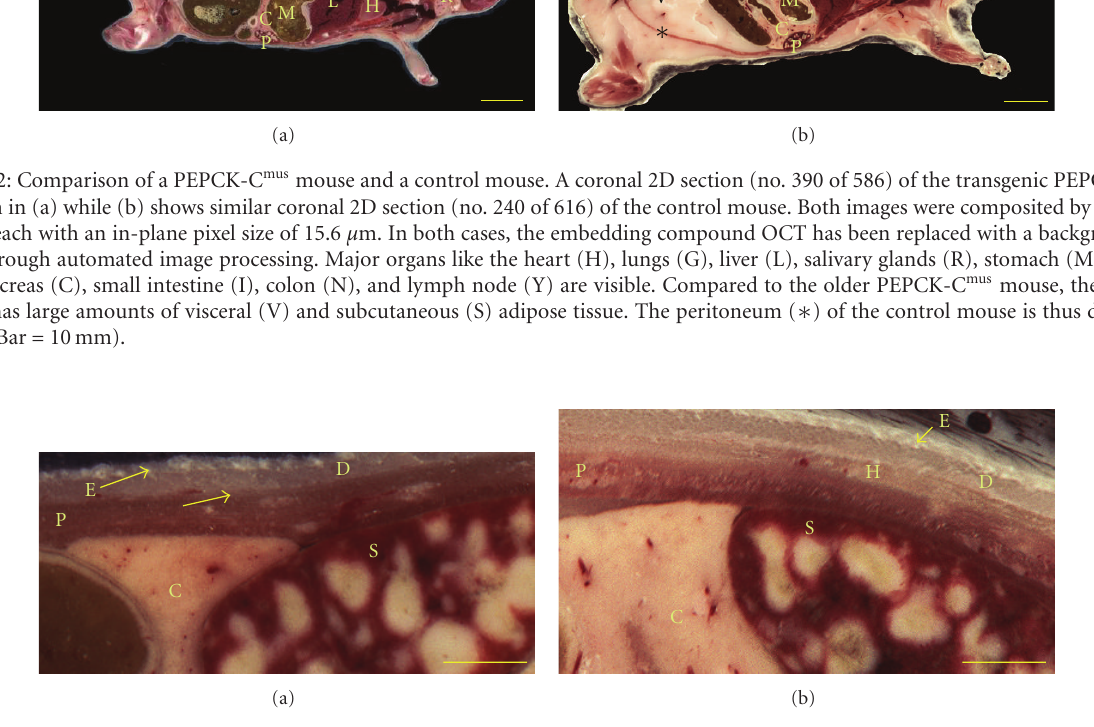
Figure 3: Comparison of coronal section images to estimate skin thickness. The hypodermis (H) of the older PEPCK-C mus mouse in (a) is thinner than that of the control (b) by 83% while the epidermis (E) of the control is 16% thinner than the transgenic. The dermis (D) of both animals was similar. The parietal peritoneum (P) thickness was also same. The pancreas (C) and spleen (S) are visible in these images. Skin thickness as an ageing marker indicates that the ageing process may be slower in the PEPCK-C mus mouse (Bar =